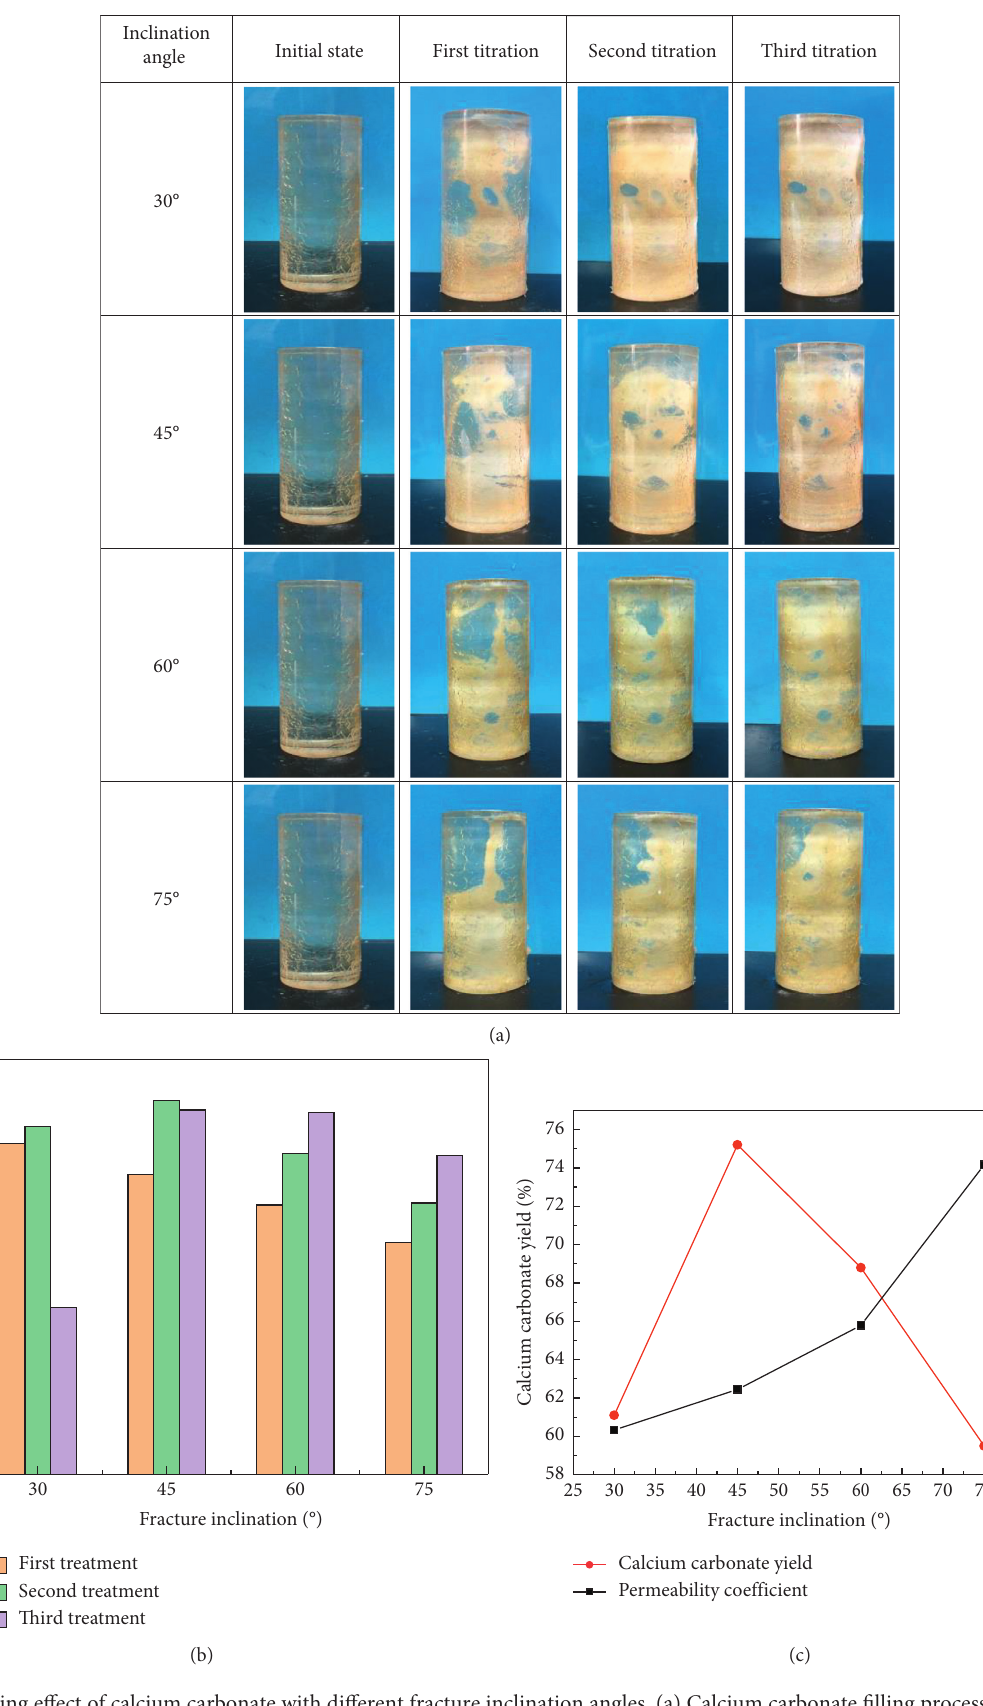
Figure 7: Filling effect of calcium carbonate with different fracture inclination angles. (a) Calcium carbonate filling process. (b) Change of calcium carbonate content. (c) Change of fracture